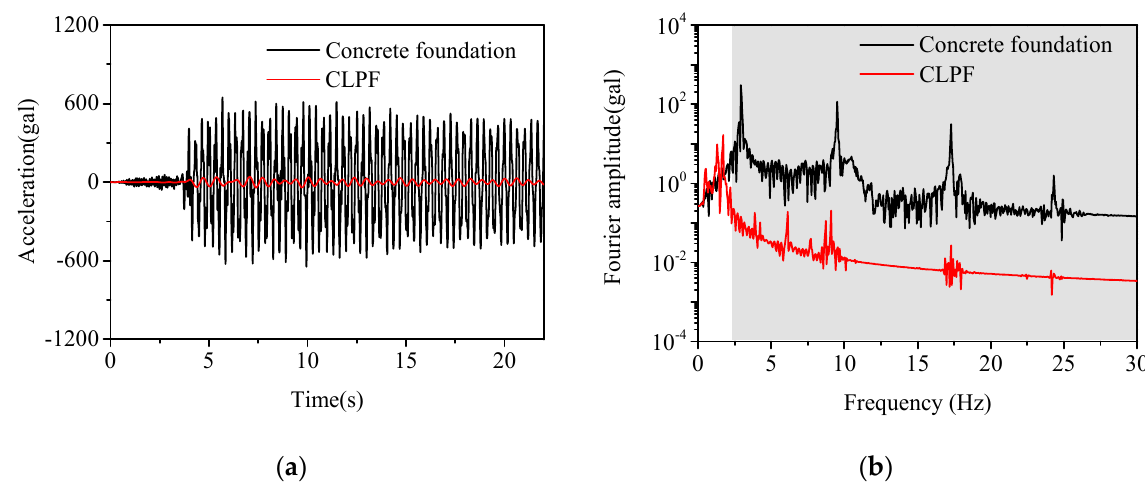
Figure 19. ( a ) Acceleration of node P under the Oroville–01 seismic wave and ( b ) its Fourier spectra.